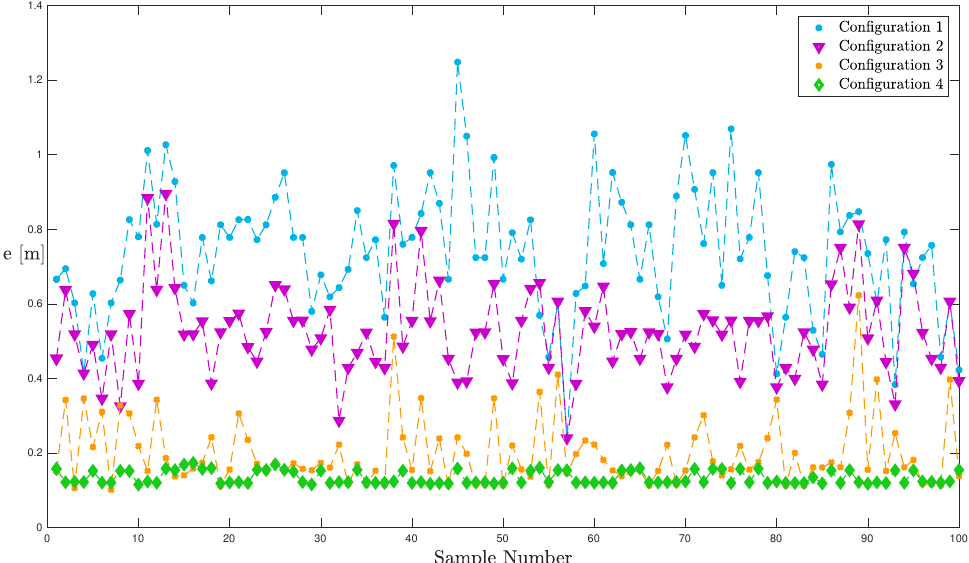
Figure 3. Samples of the localization error obtained when the TN is positioned in t 1 and the configuration of ANs is: Configuration 1 (light-blue dots), Configuration 2 (violet triangles), Configuration 3 (orange crosses), and Configuration 4 (green